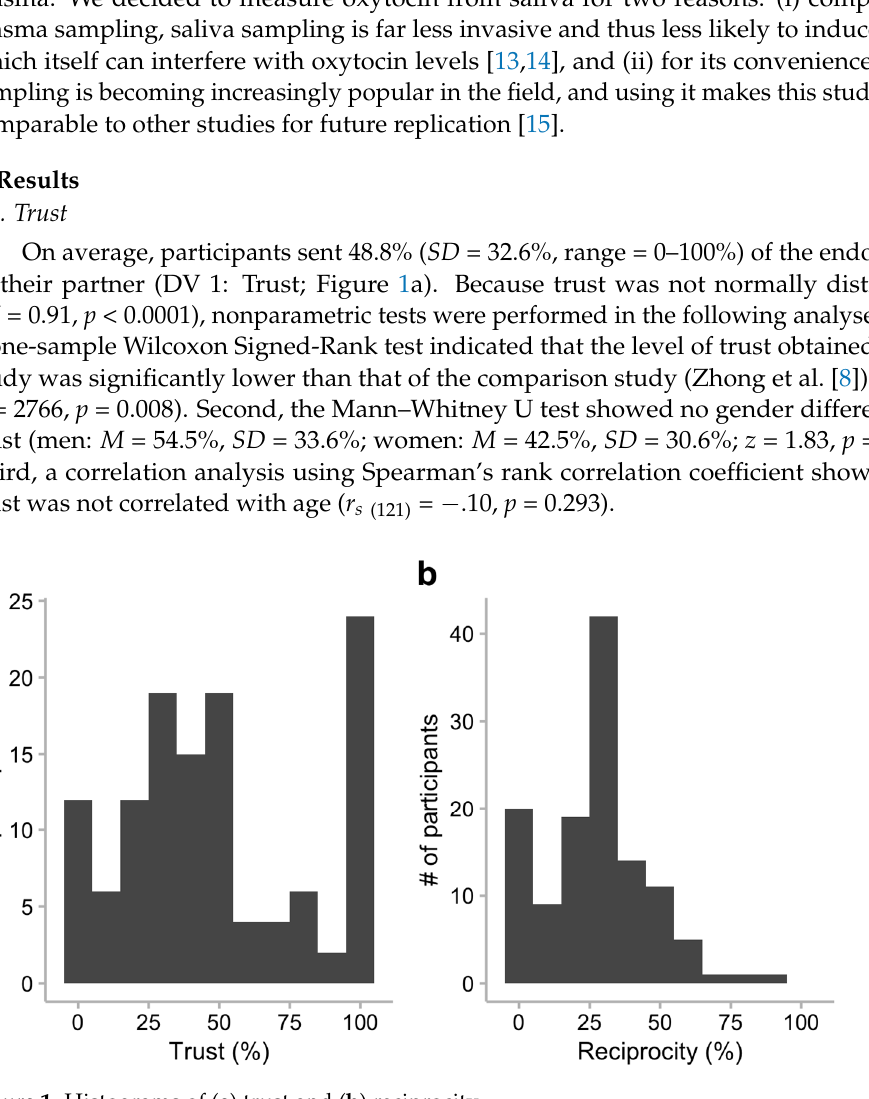
Figure 1. Histograms of ( a ) trust and ( b ) reciprocity.